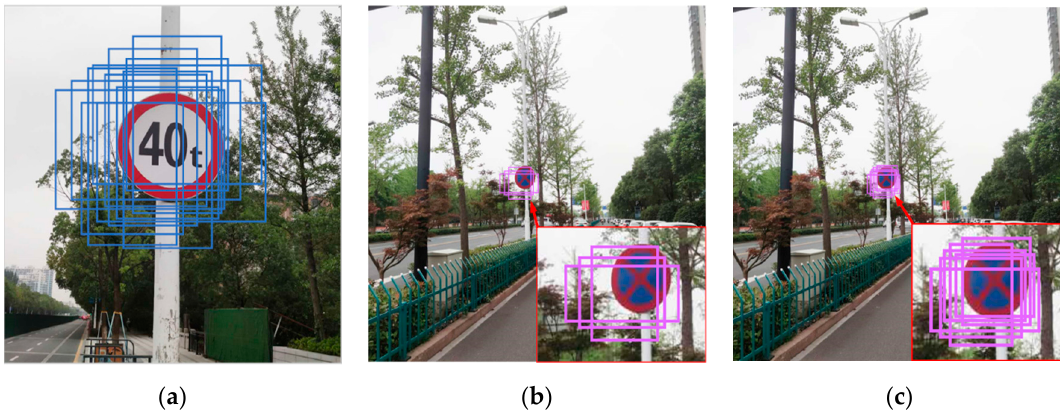
Figure 4. ( a ) shows the anchors matched by the 13 × 13 feature map of the baseline when identifying large target objects. ( b ) shows the anchors matched by the 52 × 52 feature map of the baseline when identifying small target objects. We find that even the feature map with the largest resolution in the baseline can match very few anchors when identifying small target objects. Therefore, the baseline still fails to achieve a good small target recognition effect. ( c ) shows that we assign six anchors of different sizes to the 64 × 64 feature map in the five-scale recognition network, which artificially increases the probability of small target objects being covered by anchors.